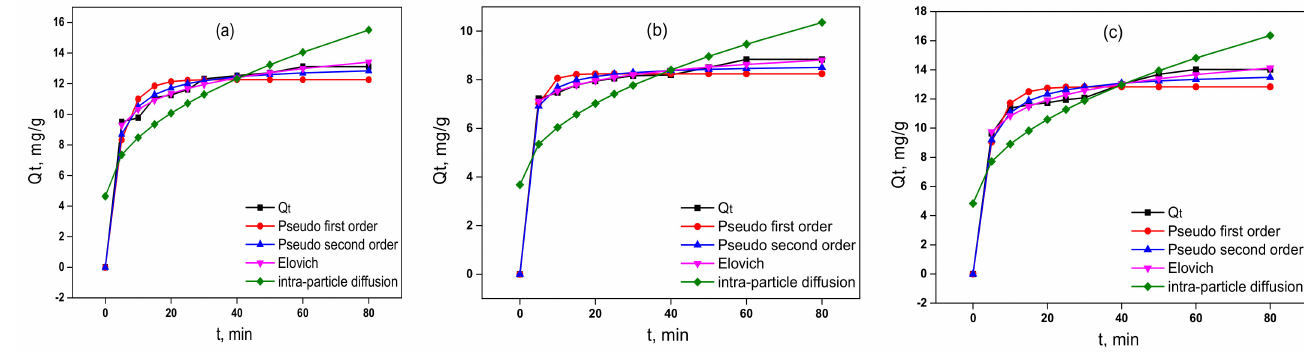
Figure 9. Graphs of nonlinear kinetics models of IC adsorption by RPS ( a ) , PST1 ( b ) and PST2 ( c